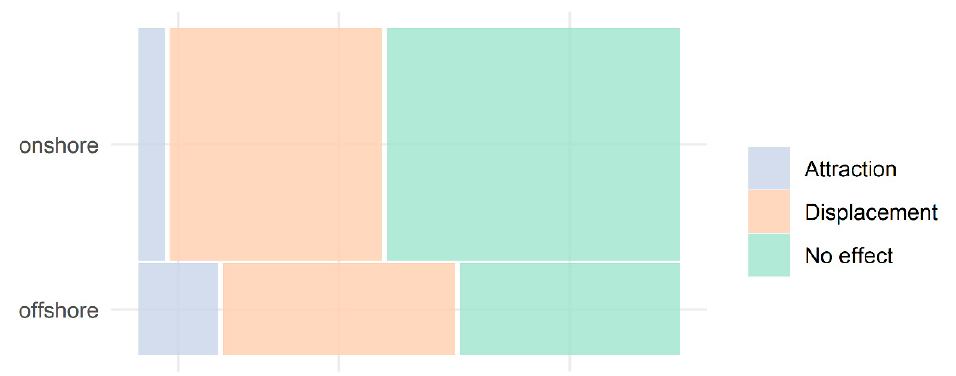
Figure 4. Relative frequency of trials ( n = 286) reporting attraction, displacement or no effects of wind turbines on bird space use or abundance, per wind farm type. The bar width represents the number of experimental trials performed per wind farm type.